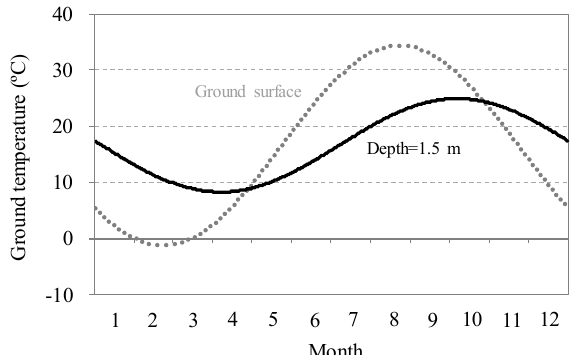
Figure 3. Ground temperature at a depth of 1.5 m and at the ground surface.